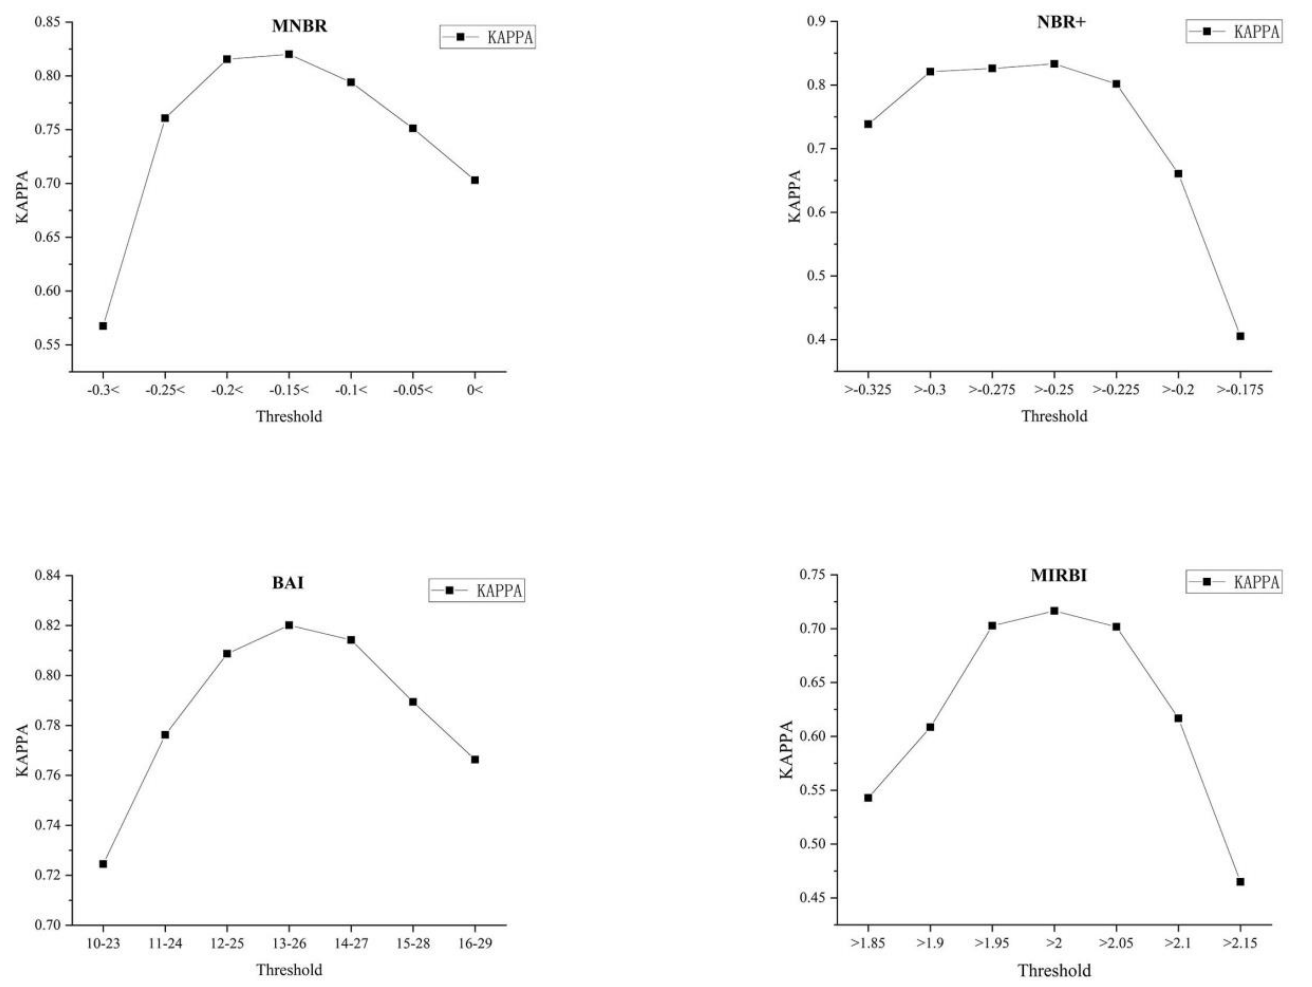
Figure 6. A sensitive analysis of different threshold segmentation to the classification accuracy.